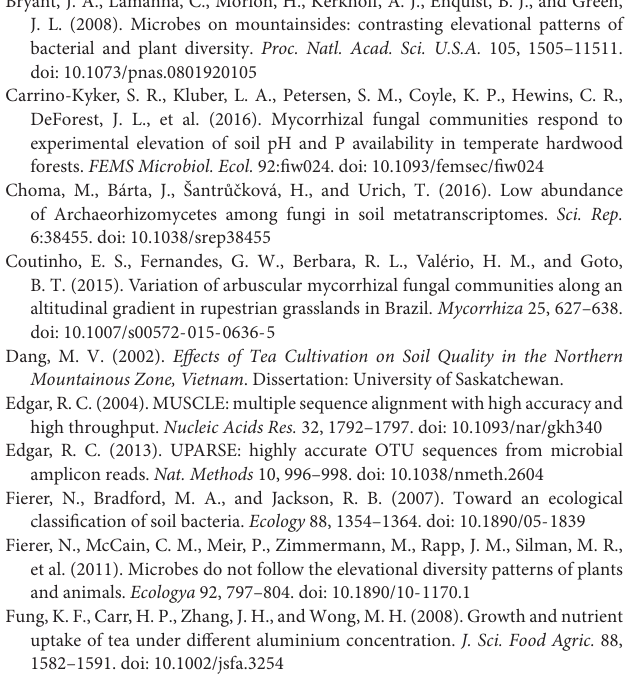
Supplementary Figure S4 | OTUs petal graph analyses of the soil bacterial (A) and fungal (B) communities in in different pH groups. Supplementary Figure S5 | NMDS analysis of soil bacterial (A) and fungal (B) communities in different pH groups. Supplementary Figure S6 | UPGMA cluster tree analysis of soil bacterial (A) and fungal (B) communities in different pH groups. Supplementary Figure S7 | Relative abundance of soil bacterial and fungal communities in different altitudes groups. (A) Relative abundance of bacteria at the genus classification level; (B) relative abundance of fungi at the genus classification level. Supplementary Figure S8 | OTUs petal graph analyses of the soil bacterial (A) and fungal (B) communities in different altitudes groups.